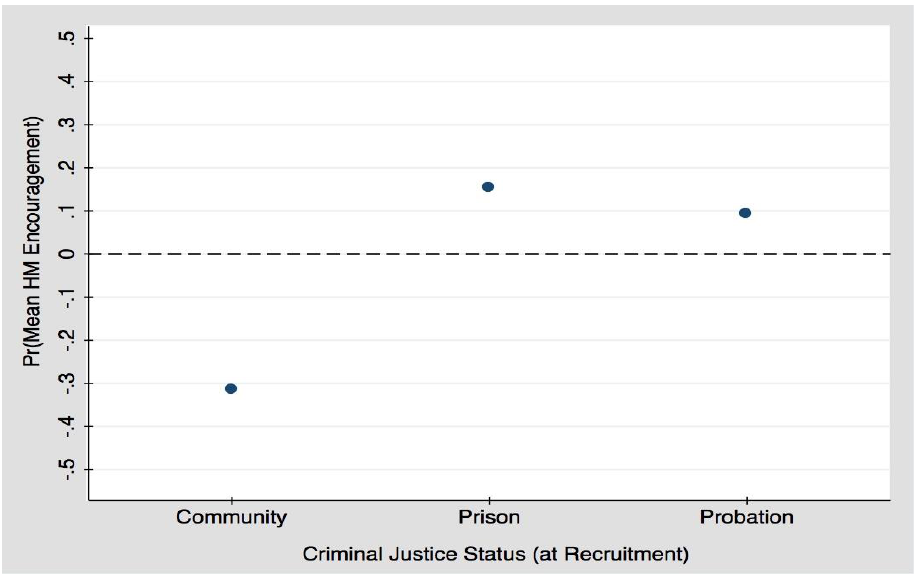
Figure 1. Predicted probability of encouragement from HM ties by criminal justice status.